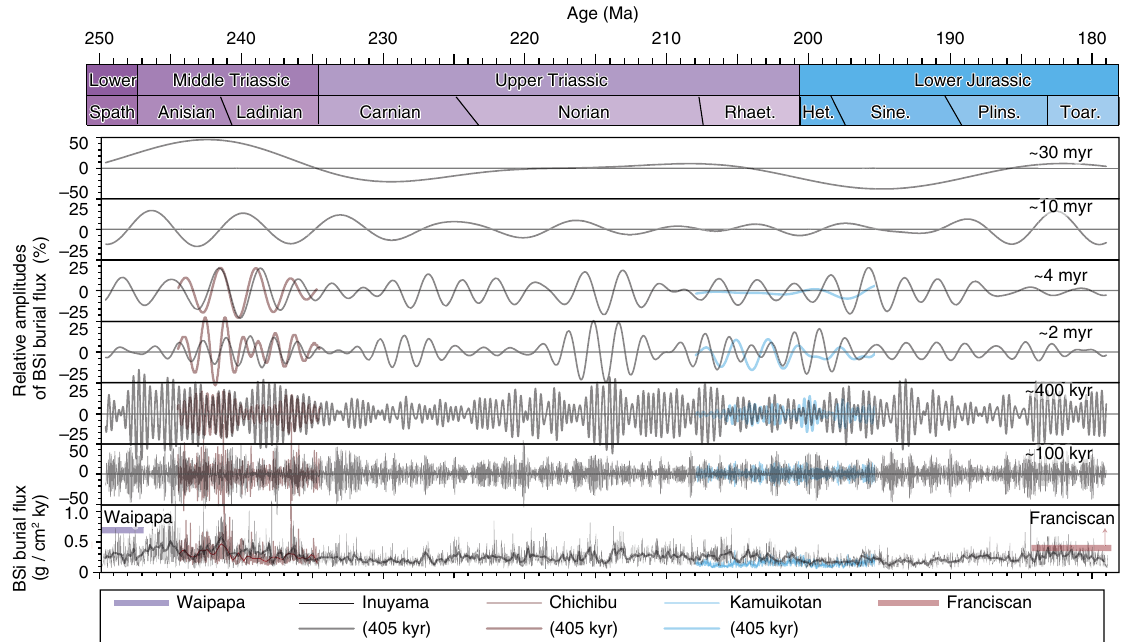
Figure 3 | Orbital-scale changes in BSi burial fluxes of cherts. Temporal variations in the BSi flux during each precession cycle (thin line) and 405kyr cycles (bold line) and the relative amplitude of the dominant orbital cycles (100kyr to 30Myr) of the early Mesozoic bedded chert sequence in the Inuyama area, central Japan. Also shown are the relative amplitudes of the dominant orbital cycles (100kyr to 4Myr) of the early Mesozoic bedded chert sequence in Chichibu and Kamiokotan areas, Japan, and average BSi flux in Waipapa area, New Zealand and Franciscan area,